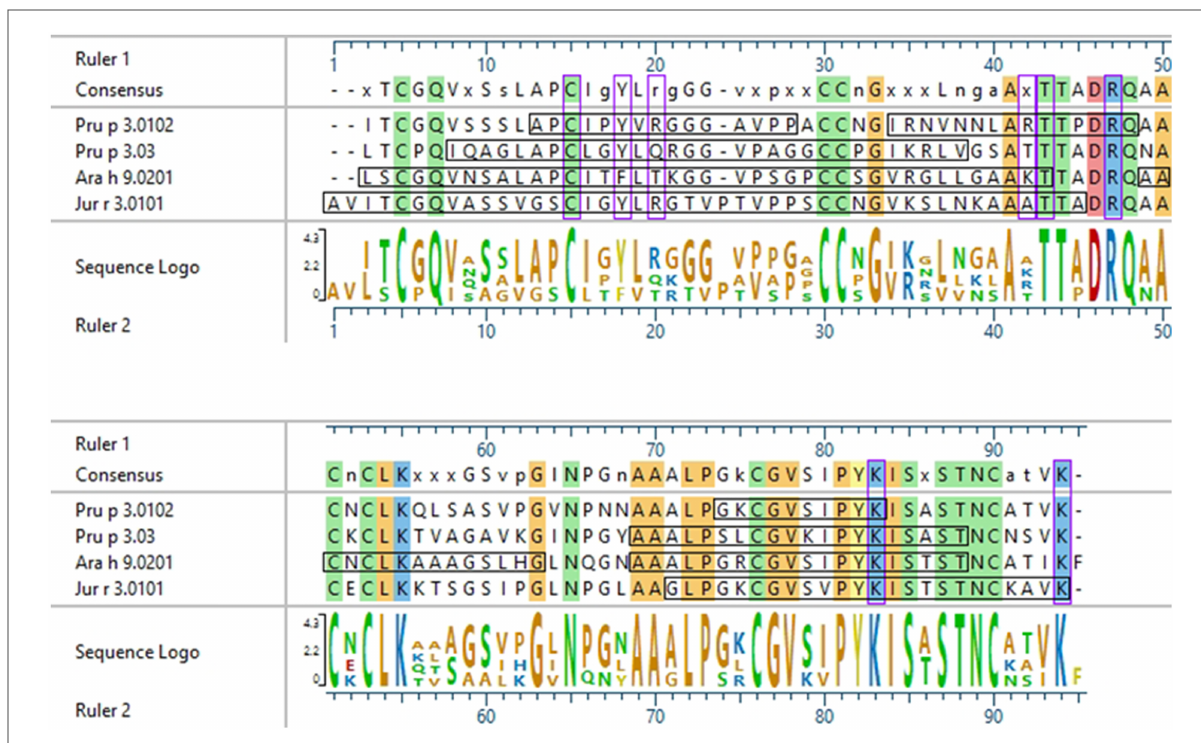
FIGURE 6 Sequence alignment of Pru p 3.0102 with LTPs from this study. ClustalW sequence alignment between Pru p 3.0102, Pru p 3.03, Ara h 9.0201, and Jug r 3.0101. Consensus sequence is shown above the alignment. Amino acids are color coded based on chemistry, with conserved residues being highlighted vertically. Horizontal black boxes indicate the major IgE binding epitopes identi fi ed in this study with US sera or in a previous study for Pru p 3.0102. Vertical purple boxes indicate the speci fi c residues previously predicted to have IgE binding